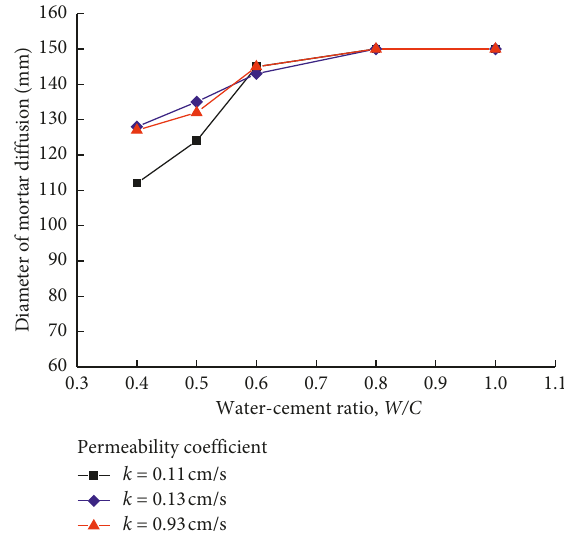
Figure 9: Characteristics of slurry diffusion ( P �